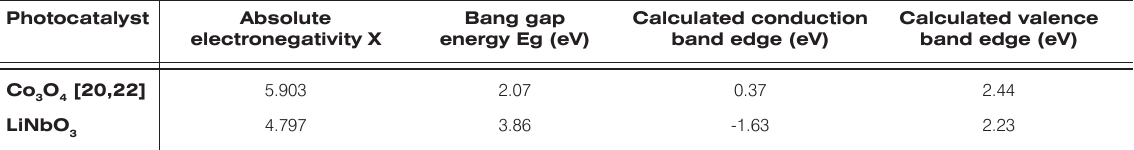
O and LiNbO 3 4